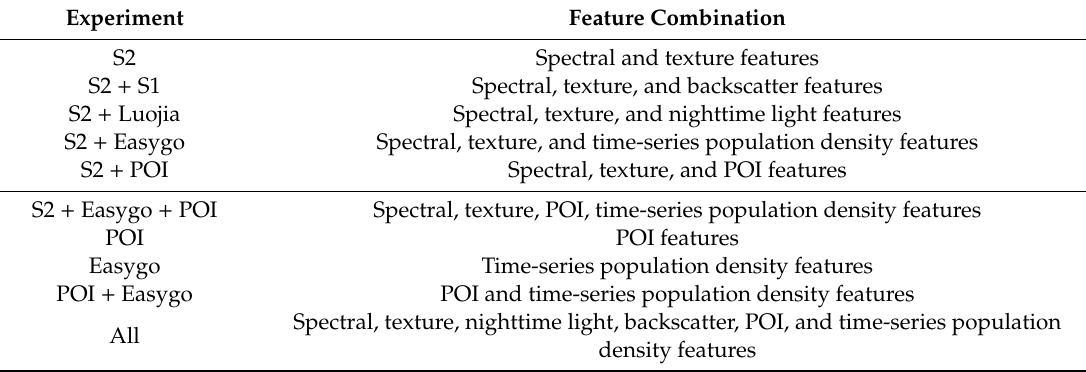
Table 3. Classification summary experiments based on di ff erent feature